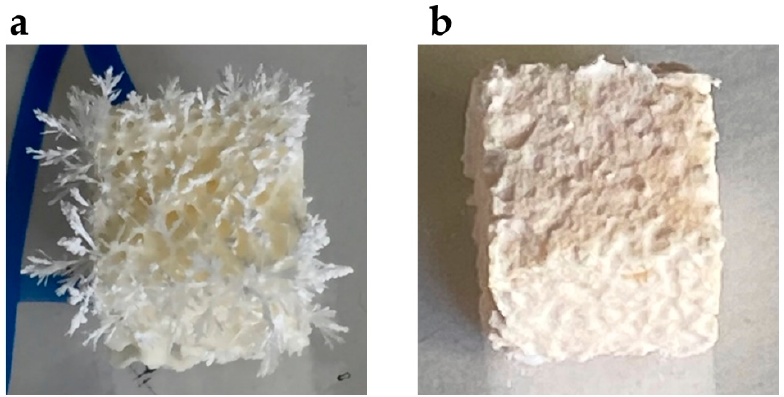
Figure 2. Crystallization of mannitol during the freeze-drying step ( a ) was prevented by the addition of NaCl ( b ).